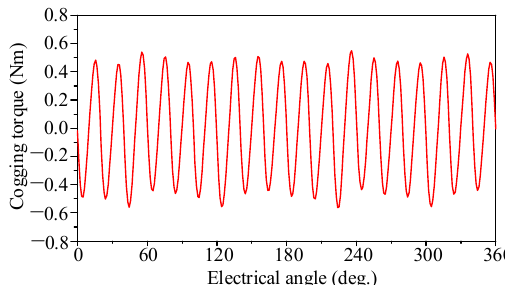
Figure 11. Cogging torque of DHPCM-SPMPs.